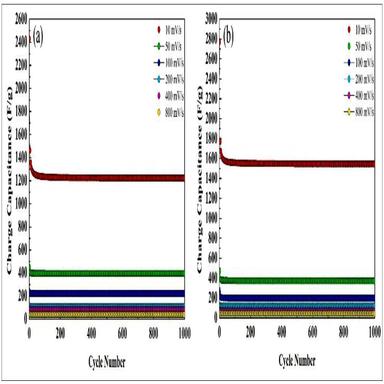
Stable charge performance during 1000 cycles at different scan rates. a) NiCeO2, b) NiCeO2@f-MWCNT/EDA.